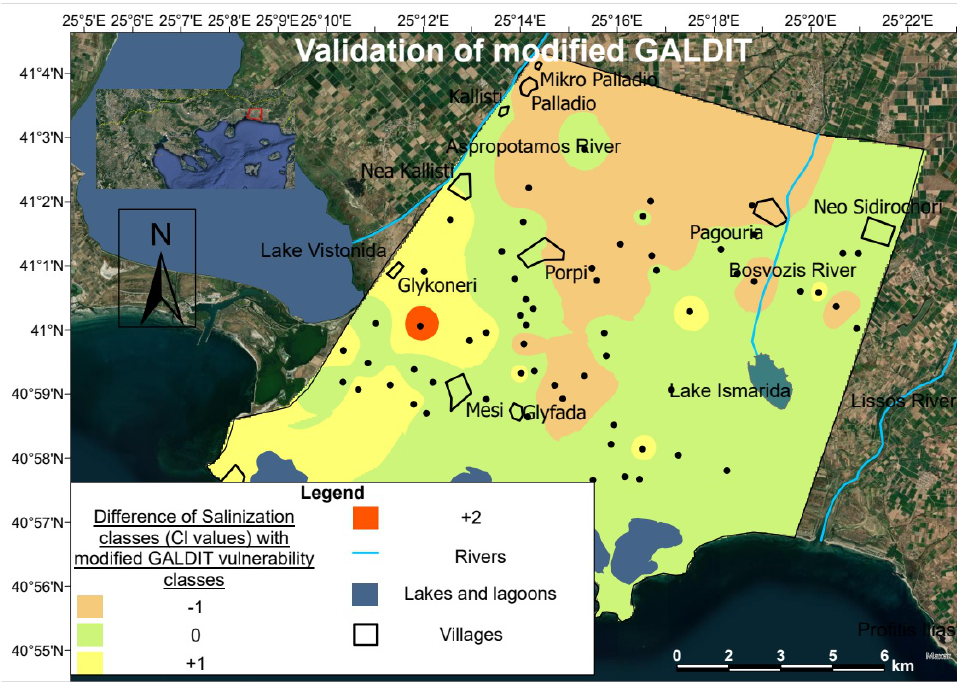
Figure 10. The difference of salinization classes (Cl − values) with modified GALDIT vulnerability classes.